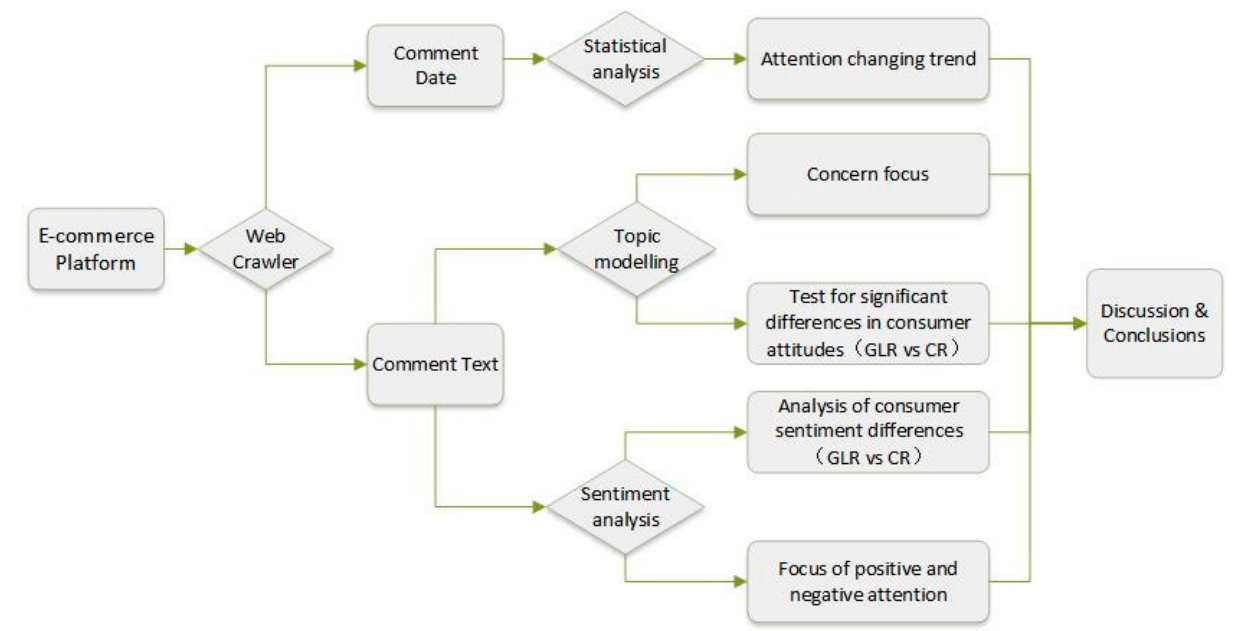
Figure 1. The analysis framework of review mining.